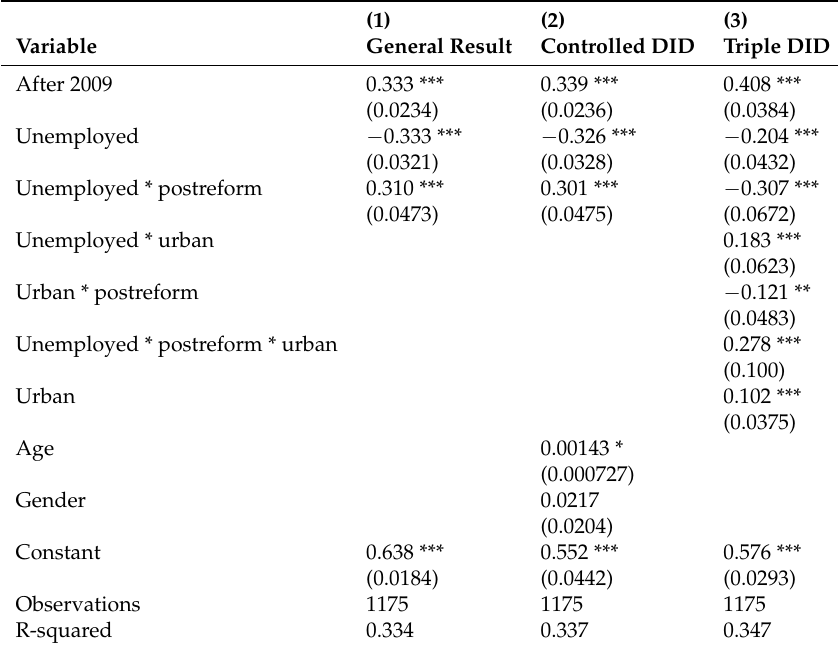
Table 5. Treatment effect of health care reform on insurance